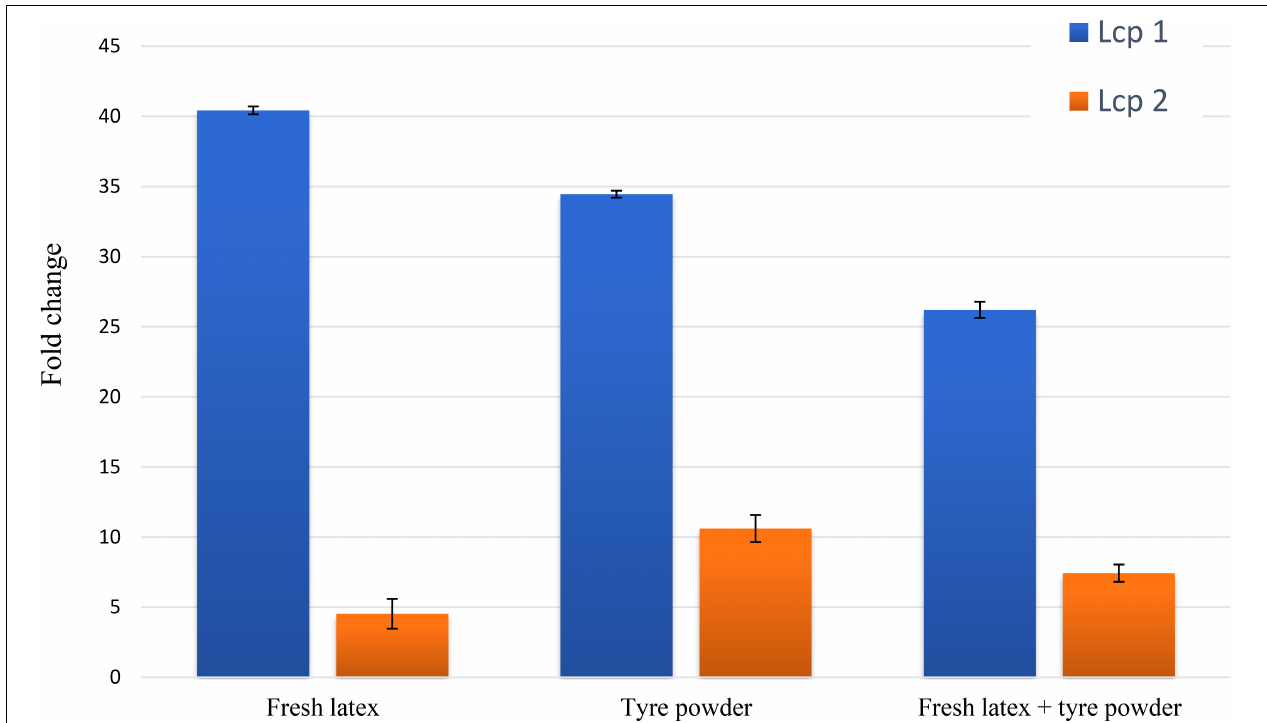
FIGURE 4 | Quantification of expression levels for Streptomyces sp. AC04842 lcp1 (blue bar) and lcp2 (orange bar) putative genes. Total RNA was isolated from Streptomyces sp. AC04842 cultivated with mineral salts medium (MSM) containing fresh latex, tire powder, and both fresh latex with tire powder, as the sole carbon source. The data are mean values ± standard deviations for three independent experiments. The mRNA expression levels were calculated based on the fold change formula of comparative Ct values. Expression values of putative lcp genes were compared with an endogenous control ( Streptomyces sp. AC04842 cultivated in glucose as the sole carbon